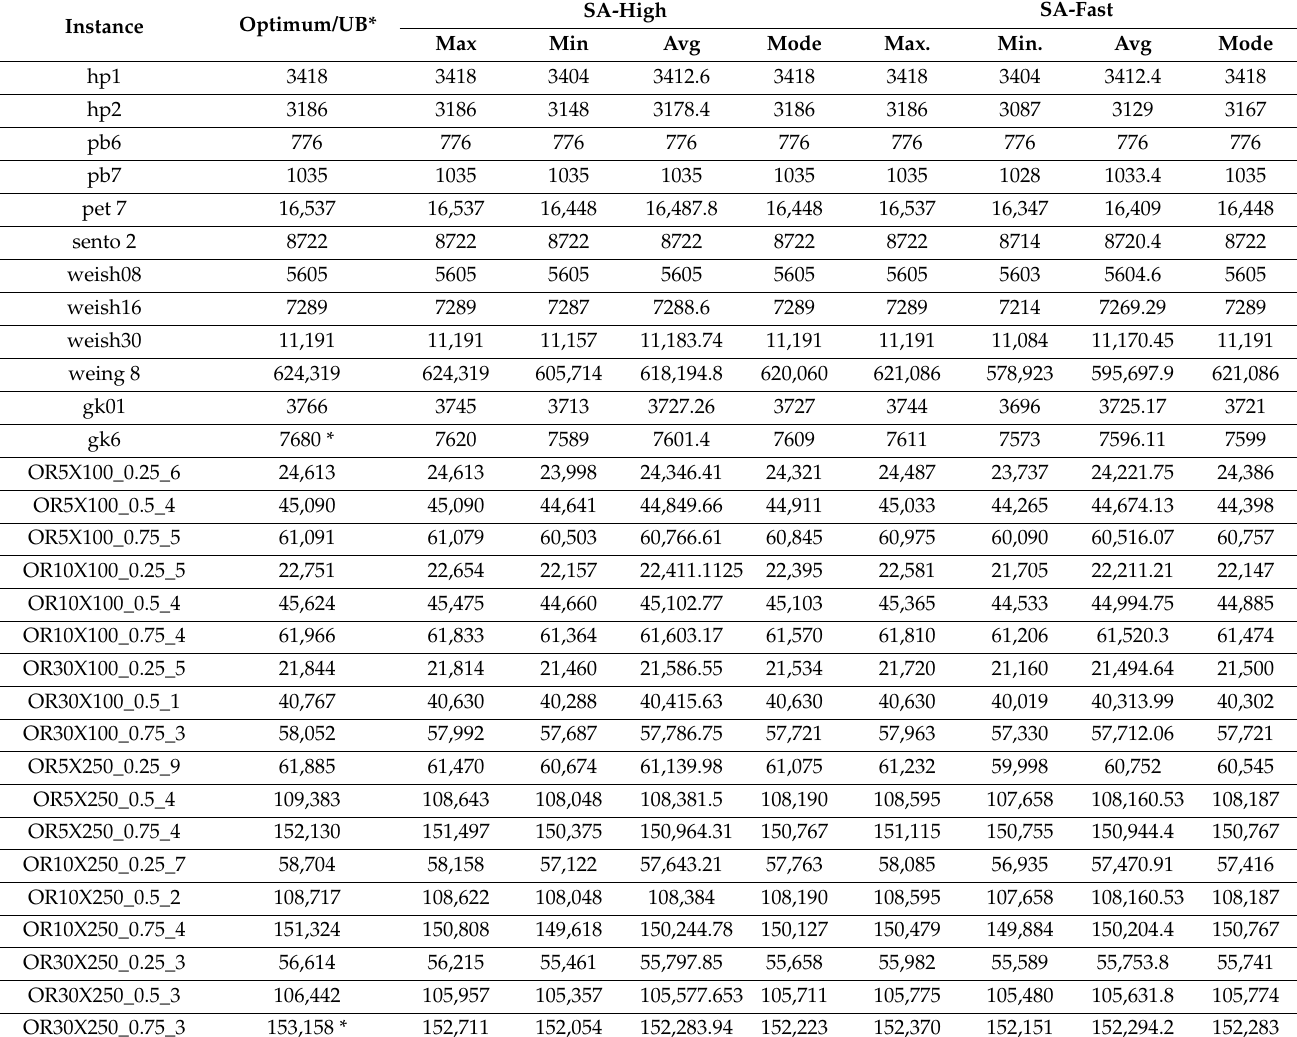
Table 9. Results for the thirty MKP benchmark problems using the SA